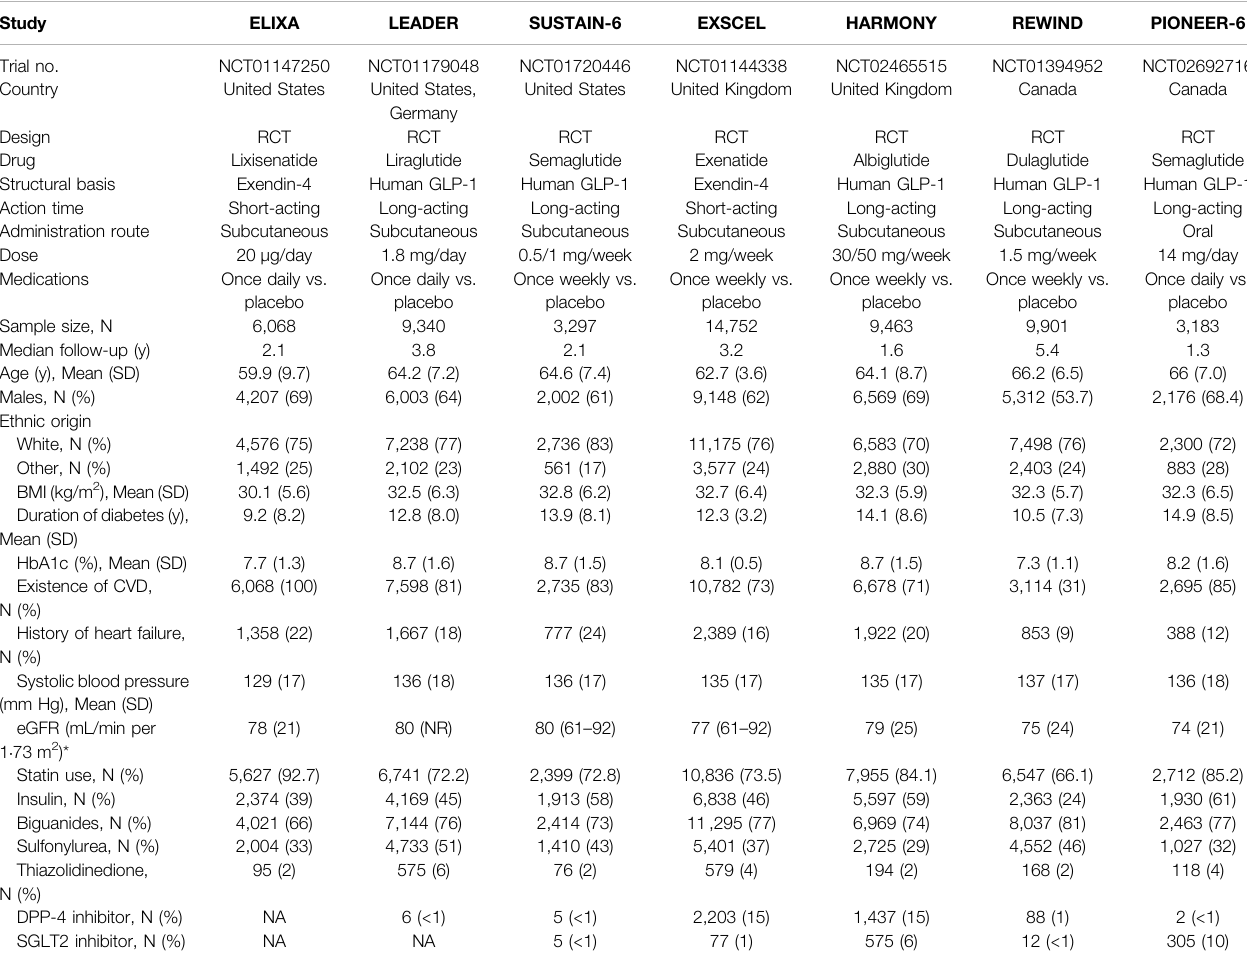
TABLE 1 | Characteristics of the studies included in the meta-analysis. Study ELIXA Trial